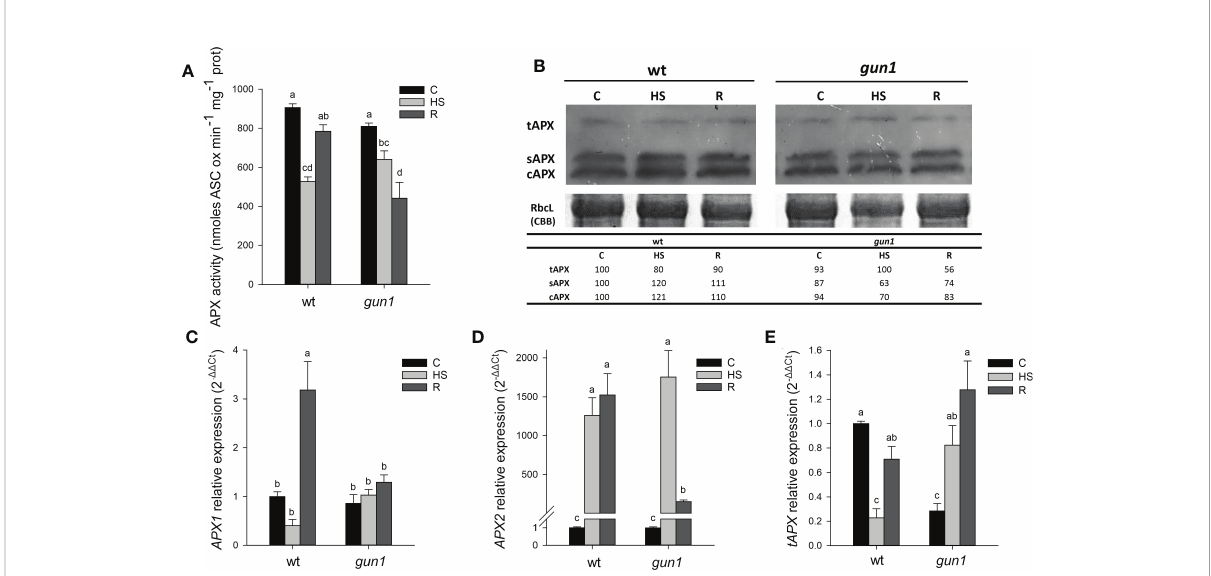
FIGURE 8 Ascorbate peroxidase (APX) behavior in 15 days-old wt and gun1 plantlets, grown at control temperature (C) or subjected to Heat Stress (HS; 2 hours at 45°C), followed by short recovery (R; 3 hours at 22°C). (A) Total APX activity; values indicate means ± standard errors (SE) of fi ve independent experiments. Letters indicate signi fi cant differences obtained by one-way ANOVA test (P< 0.05). (B) Representative image from three independent experiments of APX immuno-blotting; each well was loaded with 30 m g of proteins. CBB staining of the gel served as a loading control. Quanti fi cation of signals (by Quantity One ® ) relative to the wt in control conditions (100%) is provided below the panel tAPX, sAPX and cAPX are thylakoidal, stromal and cytosolic APX, respectively. Relative expression of (C) APX1 , (D) APX2 and (E) tAPX . The expression level of APX genes was normalized to that of Ubiquitin10 (At4g05320) and Actin8 (At1g49240) as internal references. For each sample, gene expression was related to wt in control conditions (C). Values indicate means ± SE from three independent experiments, with three technical replicates for each experiment. Different letters indicate signi fi cant differences obtained by one-way ANOVA test (p<